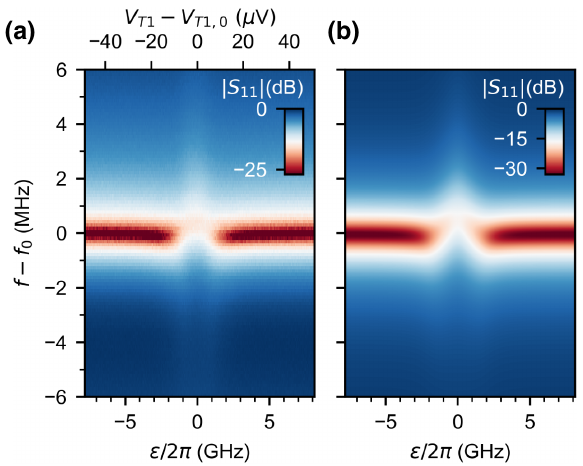
FIG. 4. Response of the resonator in the resonant regime. (a) Magnitude in dB of the power reflected at the resonator, as V T 1 is varied across the ( 6, 9 ) ←→ ( 7, 8 ) ICT. (b) Simulation results based on Eq.